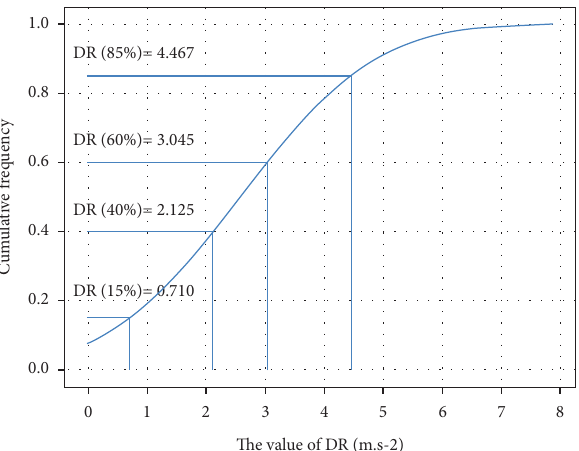
Figure 5: Cumulative frequency curve for the